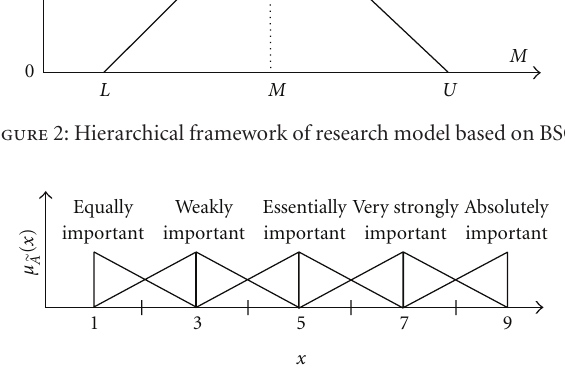
Figure 3: Membership function of a triangular fuzzy number.